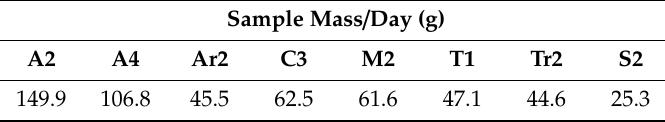
Table 5. Sample mass that can be consumed by day for aluminum.